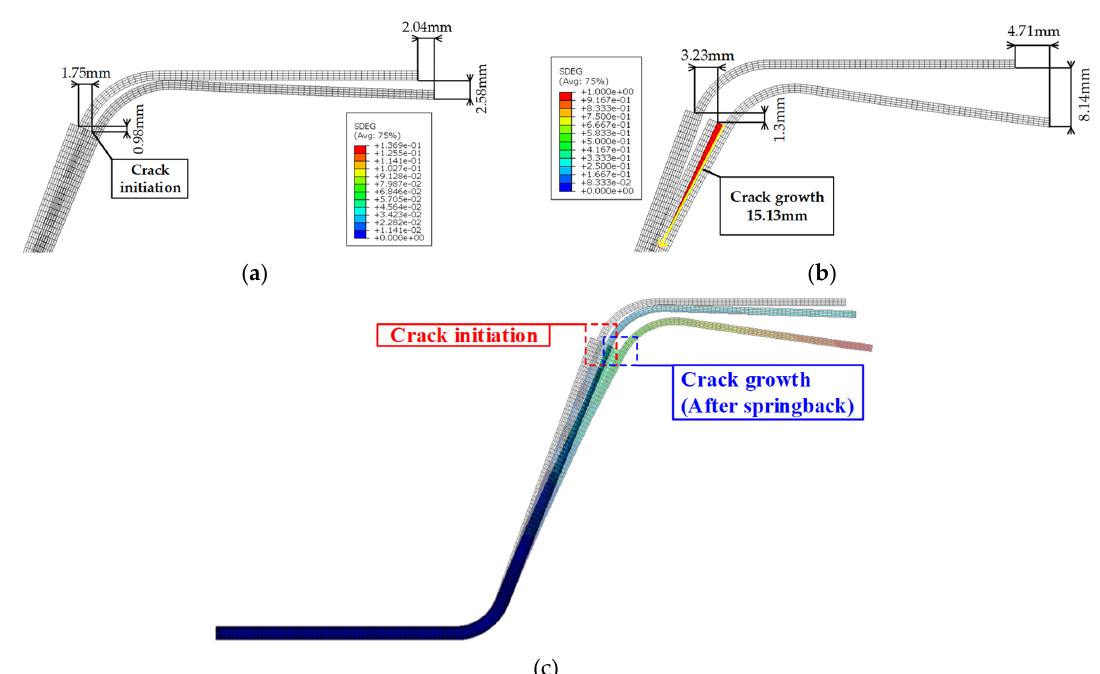
Figure 16. Results of FE simulation to predict adhesive behavior of hybrid part: ( a ) Crack initiation; ( b ) Crack growth; (c) overall shape of deformed part.